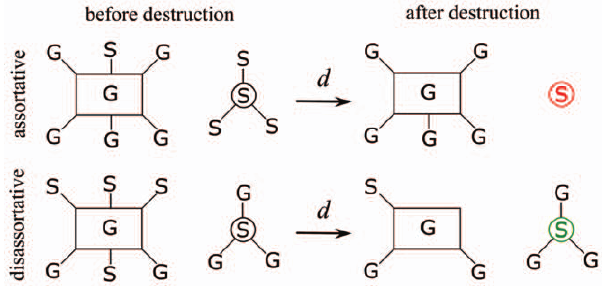
Figure 9. Protection of the links. Schematic representation of the protection against habitat destruction that generalist provide to specialist in disassortative (asymmetric) networks. (Adapted from Ashworth et al. [16]). In assortative networks the partners of specialists are other specialists. After the extinction of the most susceptible specialists their partners lose many or all their links, and remain extremely vulnerable (red). In disassortative networks, even when some species get extinct, the survivors retain some connection to the more robust generalists, therefore being protected (green).